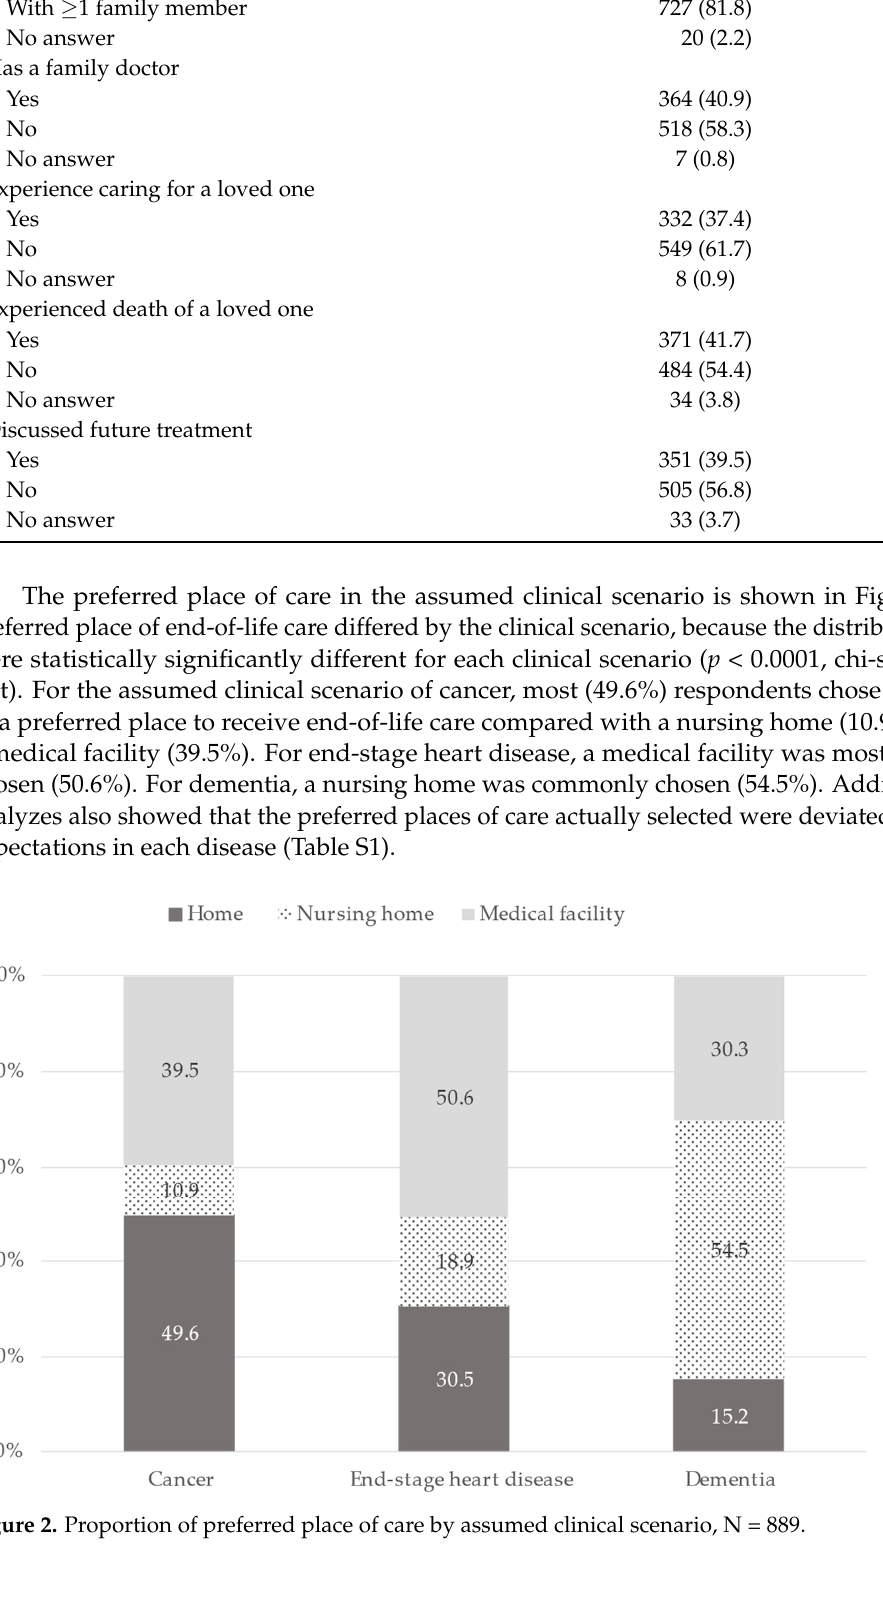
( b ) Figure 3. Proportion of preferred place of care by assumed clinical scenario stratified by age: ( a ) Age <65 ( n = 492); ( b ) Age ≧ 65 ( n = 397). Likelihood-ratio test: p < 0.001, Wald test: p < 0.001.